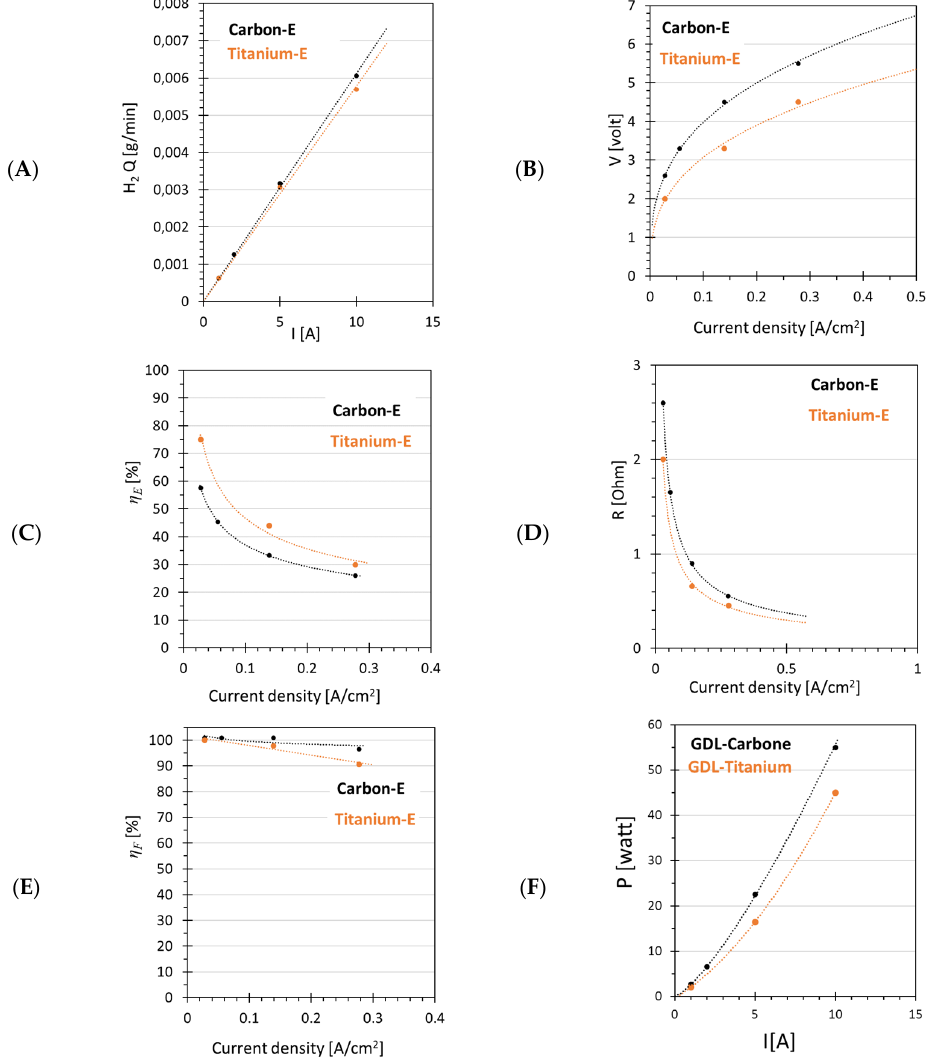
Figure 10. Effect of the cathode electrode material on the H 2 production rate ( A ), energy efficiency ( C ), Faradaic efficiency ( E ), polarization curve ( B ), resistance ( D ) and electrical power ( F ) as a function of electrical current (1 A, 2 A and 5 A and 10 A).